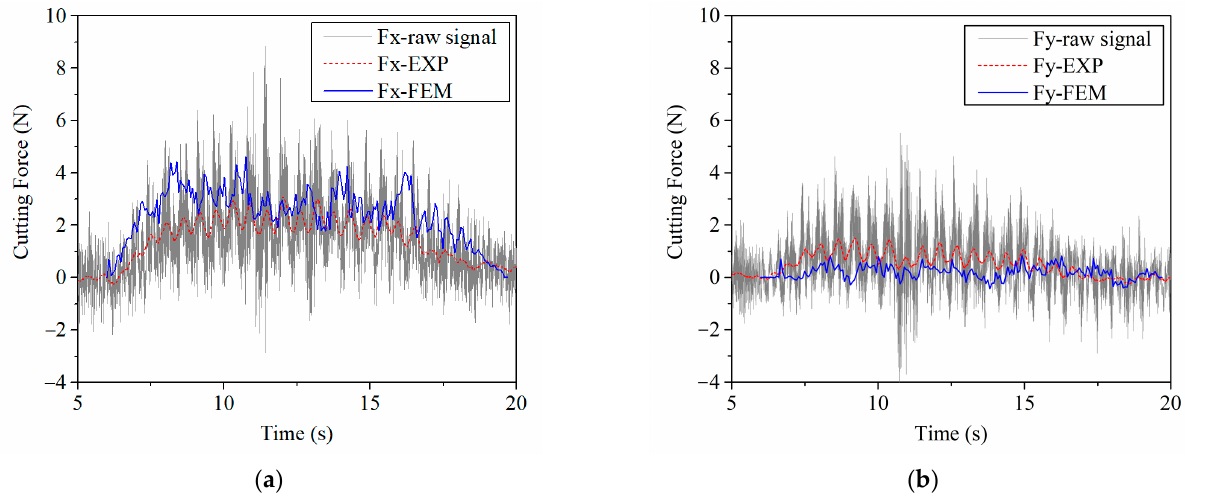
Figure 4. Comparison of cutting forces from experiments and finite element model: ( a ) X direction: along the cutting direction; ( b ) Y direction: transverse to the cutting direction.